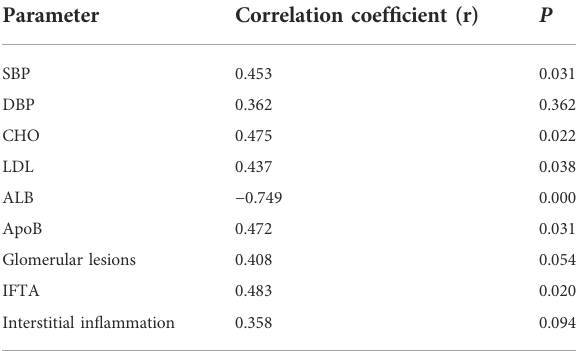
TABLE 4 Correlation between p-MLKL in renal tissue and clinical differential